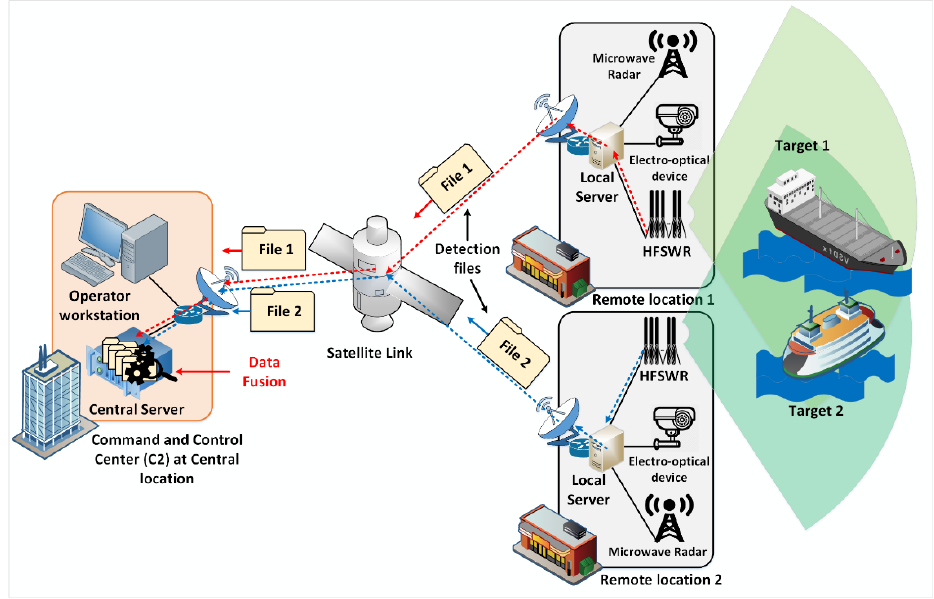
Figure 4. Complete maritime surveillance solution architecture.